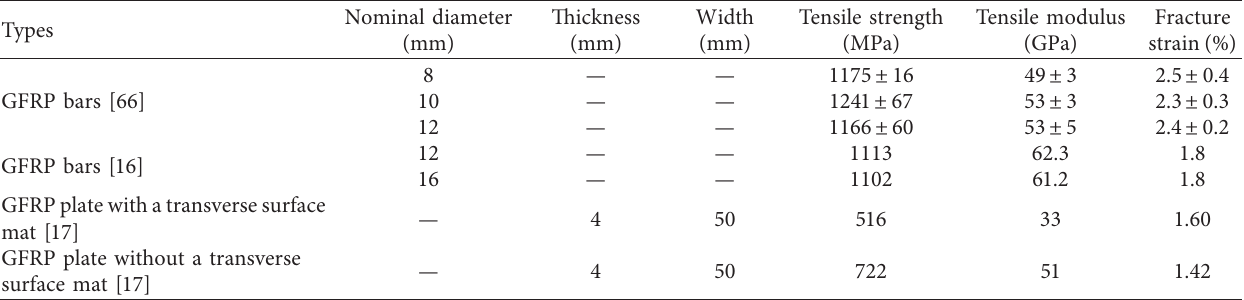
Table 3: Properties of GFRP.